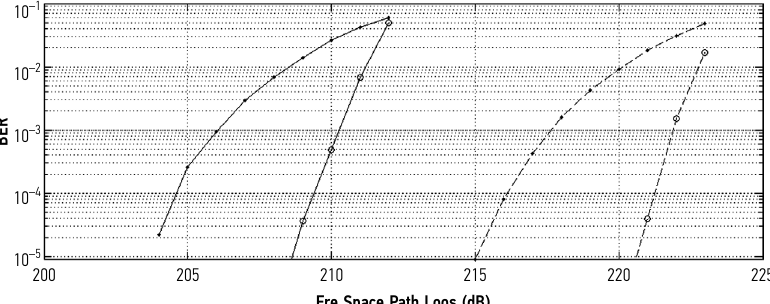
Fig. 3. Dependence of an error probability for a BPSK modulation scheme on free space path loss: dots – without coding, circles – with convolutional coding (rate 3/4, constraint length K = 7); receiver noise temperature is 20 K (dashed lines) and 290 K (solid lines); HPA back-off level is 7 dB; phase and frequency offsets are equal to zero; antennas gain G = 1;